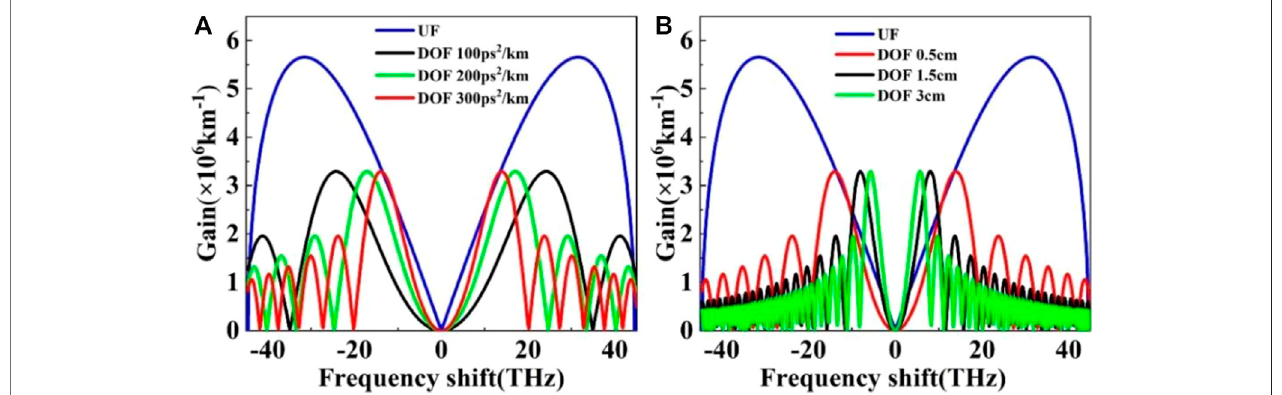
FIGURE 1 | (A) MI gain spectra at the output of DOF with different oscillation amplitudes and UF ( P 0 (cid:2) 1.224 kW, Λ (cid:2) 0.5 cm, φ (cid:2) 0), (B) MI gain spectra at the output of DOF with different oscillation periods and UF ( P 0 (cid:2) 1.224 kW, β 21 (cid:2) 300 ps 2 /km, φ (cid:2) 0).